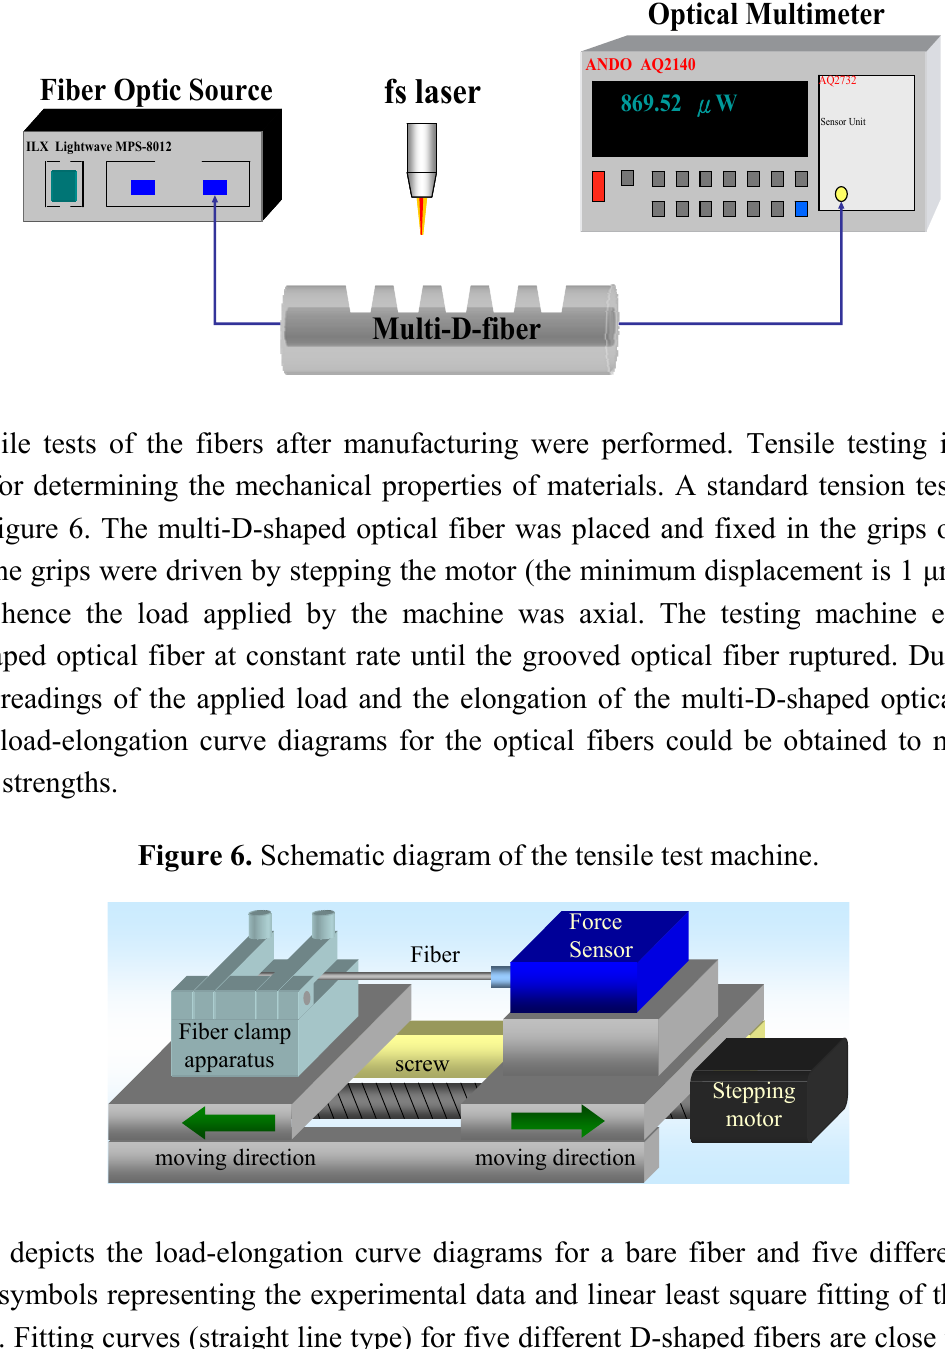
Figure 5 . Experimental setup for monitoring the transmission power loss of multi-D-shaped optical fibers during fabrication process.